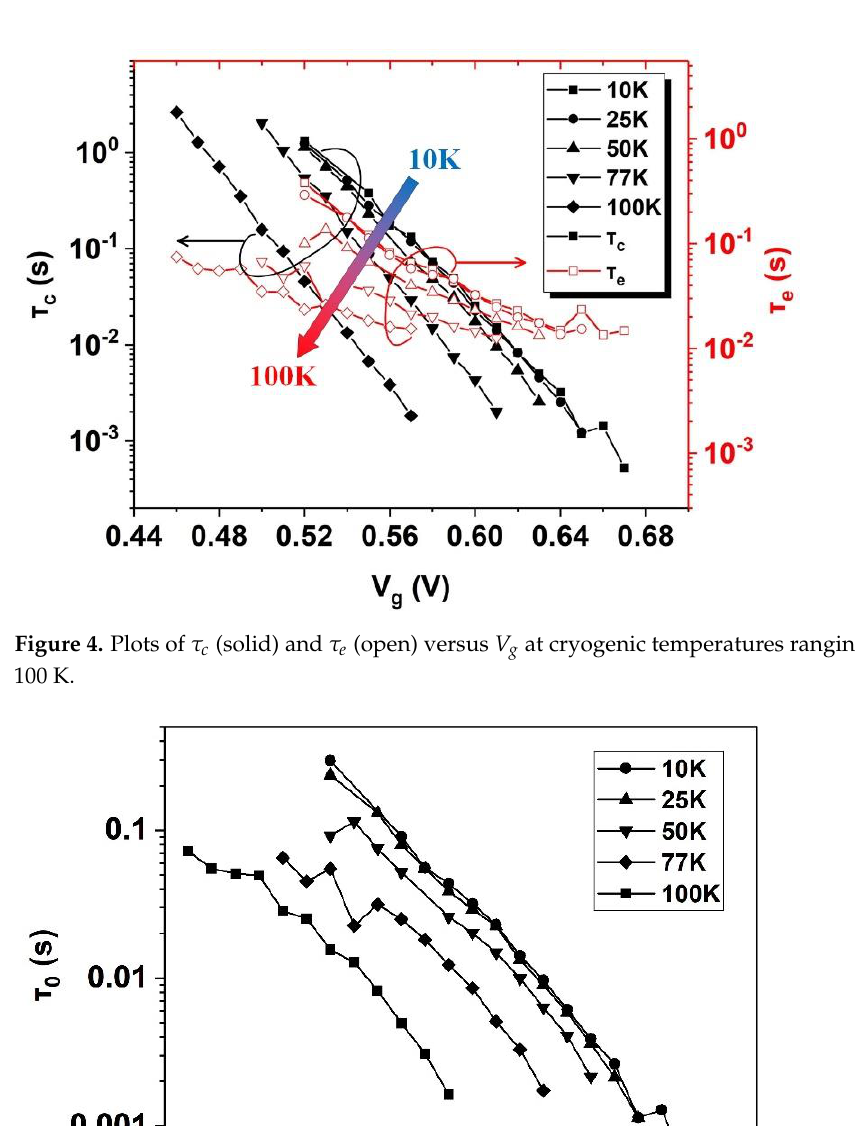
Figure 4. Plots of 𝜏 𝑐 (solid) and 𝜏 𝑒 (open) versus 𝑉 𝑔 at cryogenic temperatures ranging from 10 K to 100 K.